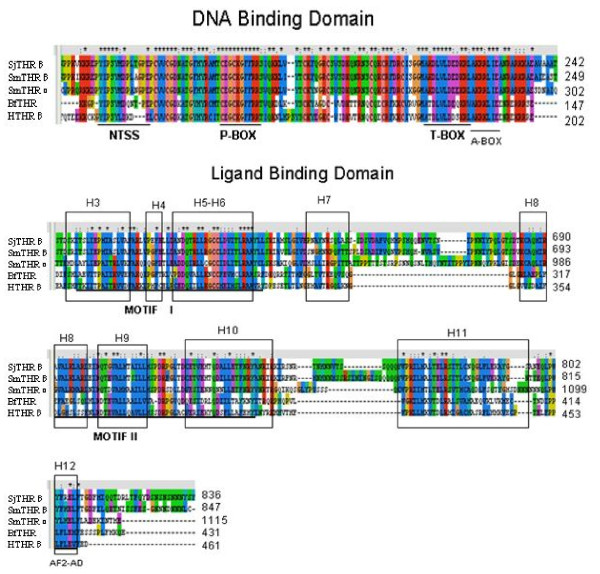
Sequences alignment. NTSS denotes N-terminal signature sequence. The P-Box, T-Box and A-Box are noted by single underline, respectively. Helices 3–12 within the LBD were marked by solid boxes. The Motif I and Motif II regions were underlined in the LBD. The AF2-AD in the LBD was noted by single underline. Asterisks indicate the conserved residues. The conserved residues of these sequences are highlighted with the same color. The number at the end of each line indicates the residue position in the original sequence. Sequences used in the mutiple alignment include: Schistosoma mansoni SmTHRβ (GenBank accession number AAR29359.1), Schistosoma mansoni SmTHRα (GenBank accession number XP_002573733.1), Branchiostoma floridae BfTHR (GenBank accession number ABS11249.1), Homo sapiens HTHRβ (GenBank accession number NP_001121649.1), Schistosoma japonicum SjTHRβ.